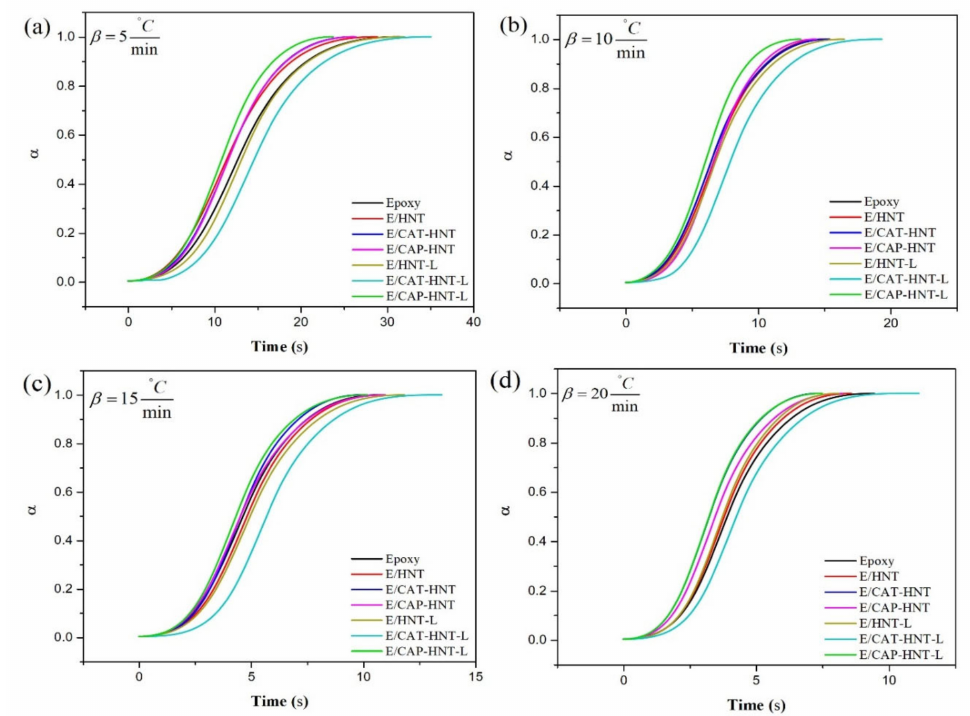
Figure 10. Fractional extent of conversion vs. time for epoxy and epoxy/HNT nanocomposites at heating rates of ( a ) 5, ( b ) 10, ( c ) 15, and ( d ) 20 ◦ C min − 1